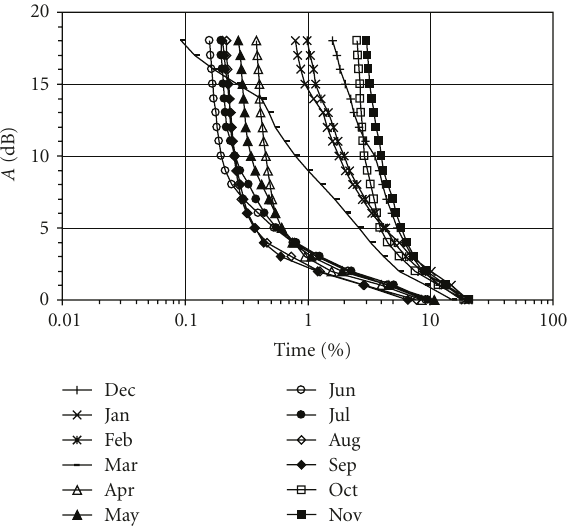
Figure 3: Obtained monthly CDs of attenuation due to all the hydrometeors combined on the RF path over the 6-year